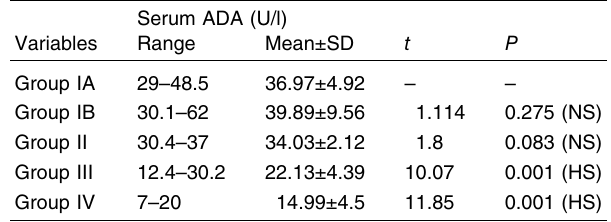
Table 4 Comparison between group IA versus other groups as regards serum ADA Serum ADA (U/l) Variables